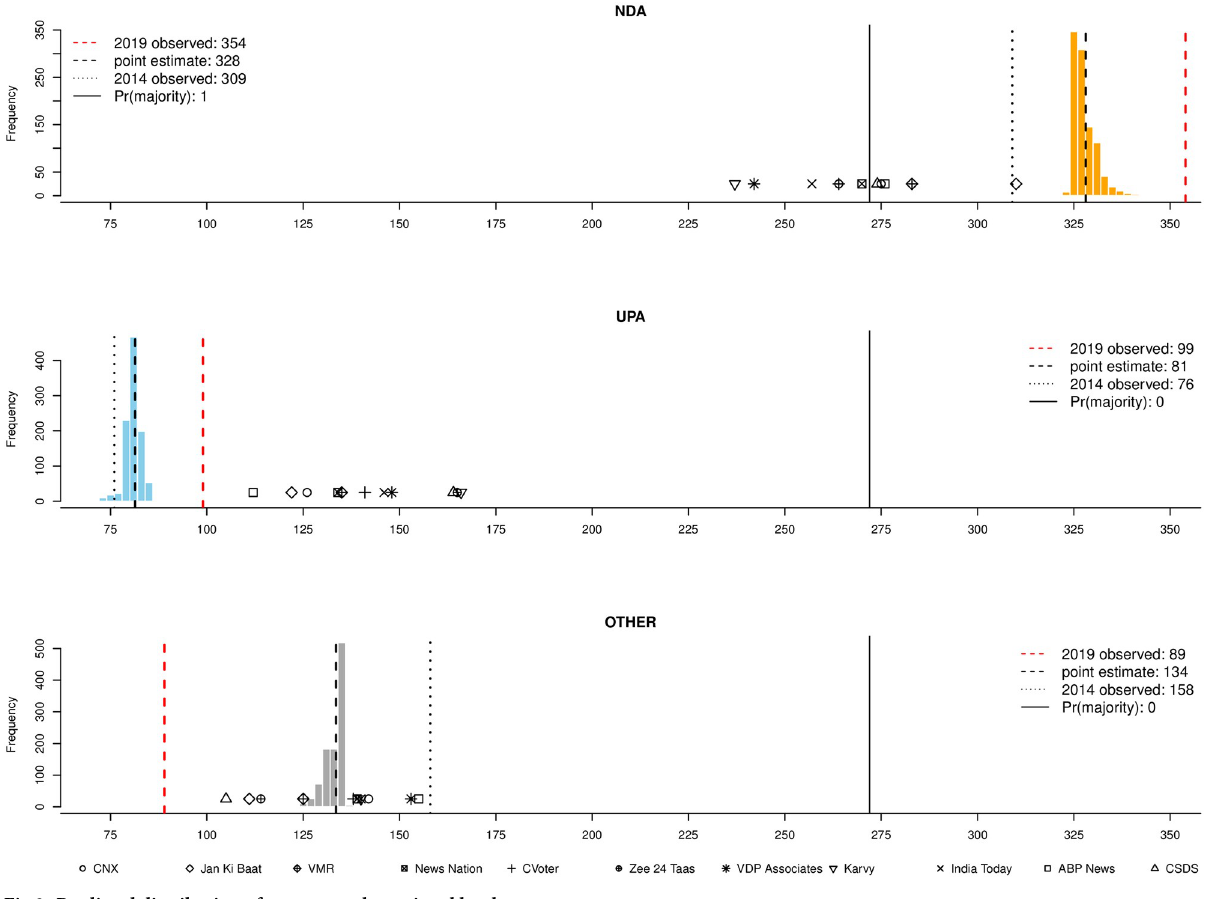
Fig 2. Predicted distribution of turnout at the national